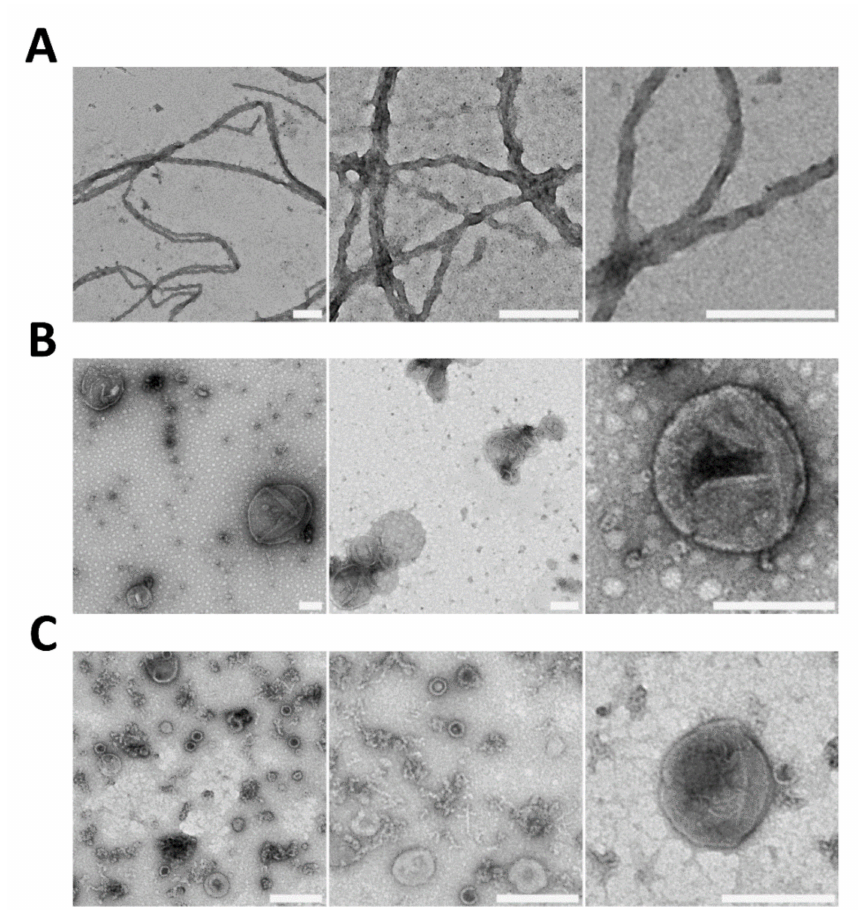
Figure 3. Electron micrographs of negatively stained ( A ) recombinant full-length Sup35p fibrils as- sembled in vitro, ( B ) extracellular vesicles (EV) purified from yeast culture medium and ( C ) periplas- mic vesicles (PV) extracted from the yeast periplasm (scale bar: 200 nm)